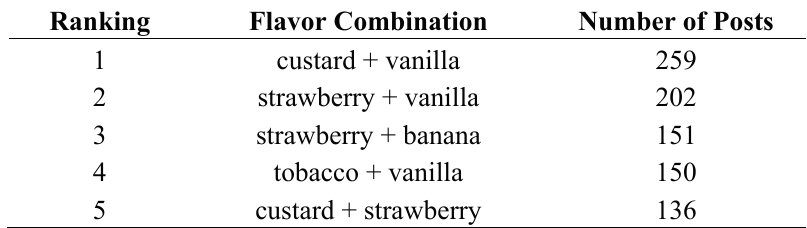
Figure 2. Most popular flavors in multi-flavor posts. Table 3. Most popular two-flavor combinations.